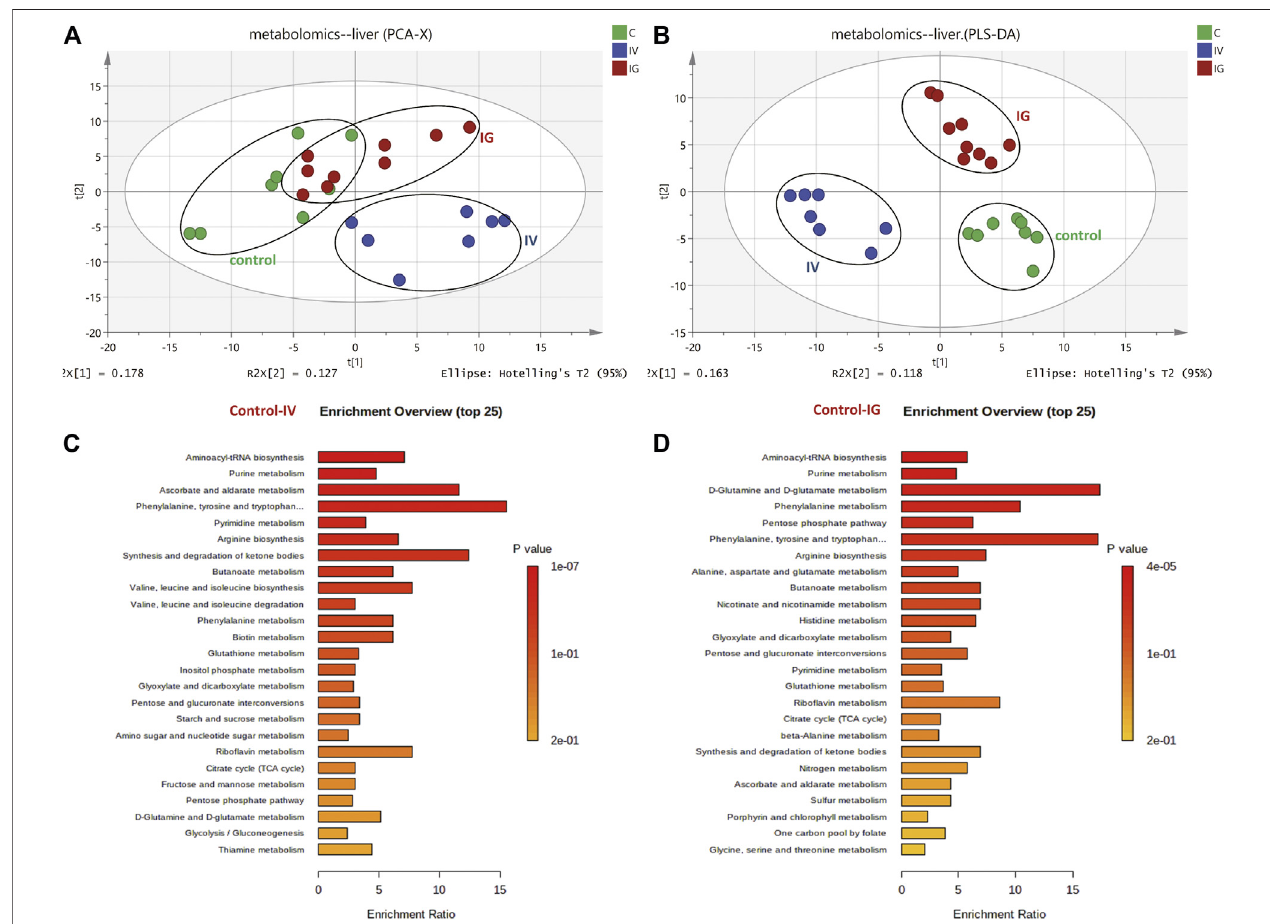
FIGURE2| EffectofMesoporousSilicaNanoparticles(MSNs) onmouselivermetabolitesbydifferentexposuremethods(IVandIG)usingHPLC – MSandGC – MS. (A) Principal component analysis (PCA) scoring maps of metabolites. (B) Partial least squares discriminant analysis (PLS-DA) scoring maps of metabolites. (C) KEGG metabolic pathway of the liver samples between the control and IV groups. (D) KEGG metabolic pathway of the liver samples between the control and IG groups.